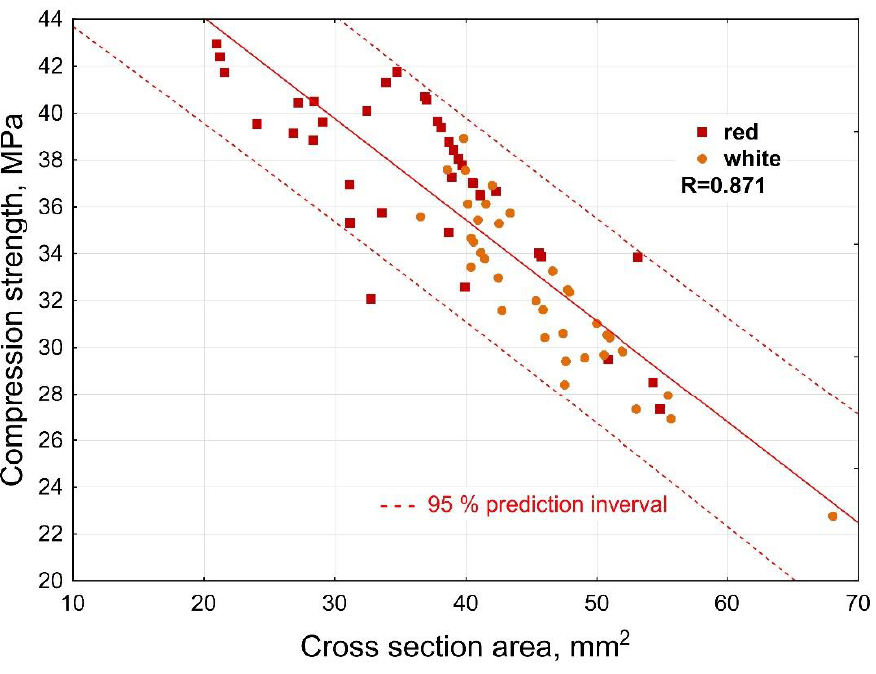
Figure 4. Correlation between compression strength and cross-section of grape cuttings. Dashed lines limit 95% of the prediction interval.